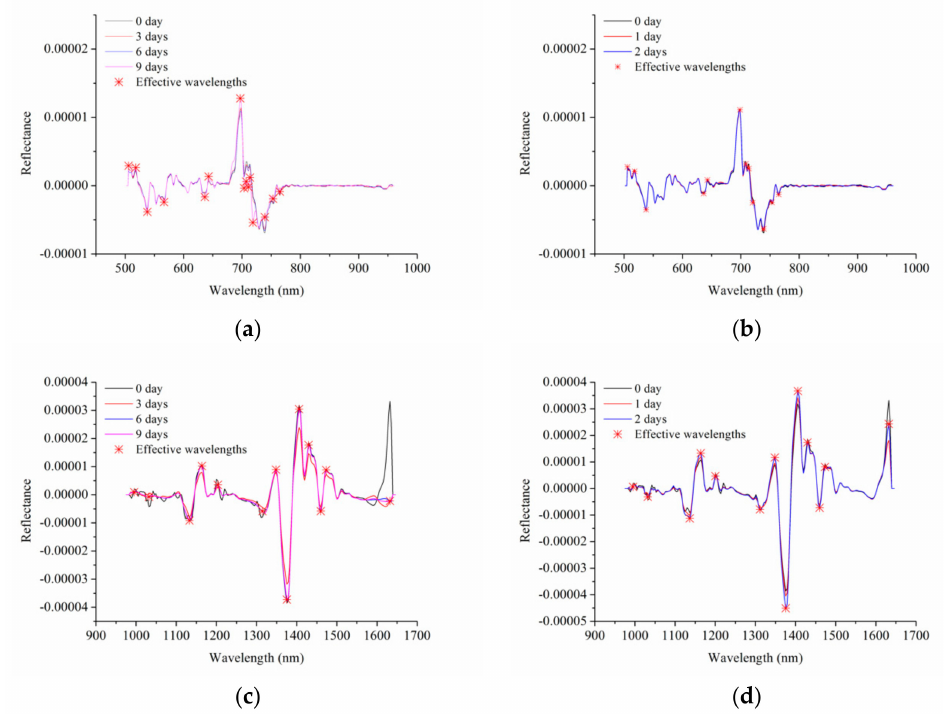
Figure 4. E ff ective wavelengths selected by second-order derivative spectra of spinach leaves stored at ( a ) 4 ◦ C and ( b ) 20 ◦ C based on Vis-NIR hyperspectral data. E ff ective wavelengths selected by second-order derivative spectra of spinach leaves stored at ( c ) 4 ◦ C and ( d ) 20 ◦ C based on NIR hyperspectral